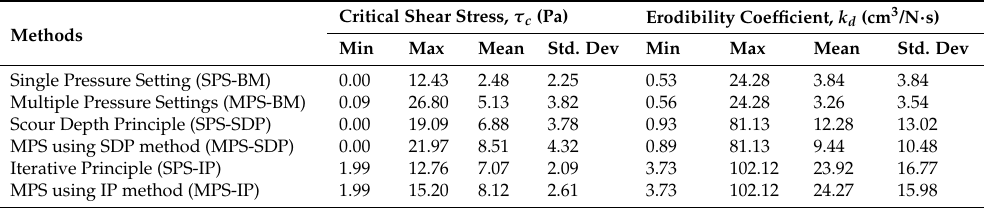
Table 3. Statistical summary of erodibility parameters computed using different